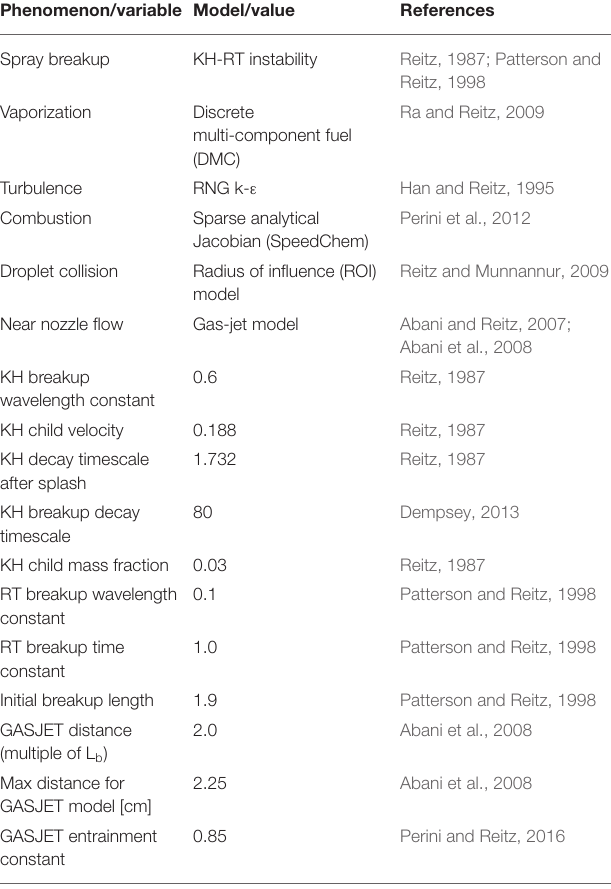
TABLE 1 | Sub-models and spray model constants used in CFD simulations. TABLE 2 | Stock Caterpillar 3401E SCOTE engine geometry, thermal boundary conditions, and direct-injector parameters used in CFD